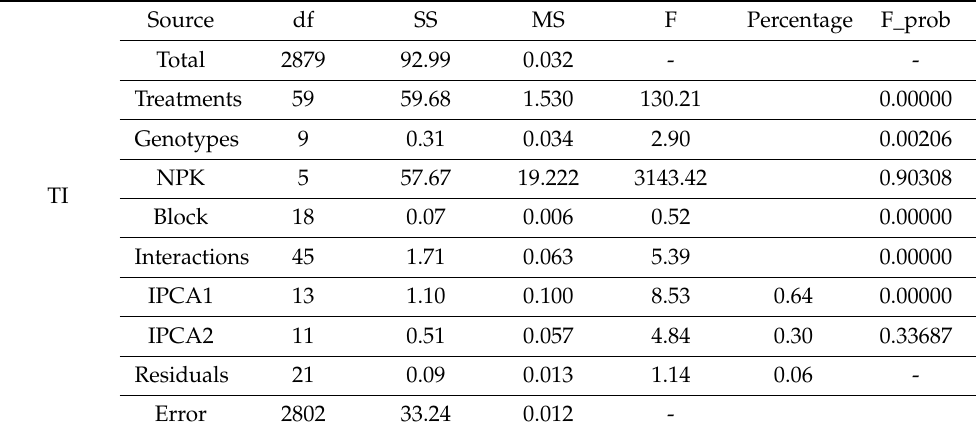
Table 5. Results of the AMMI Variance